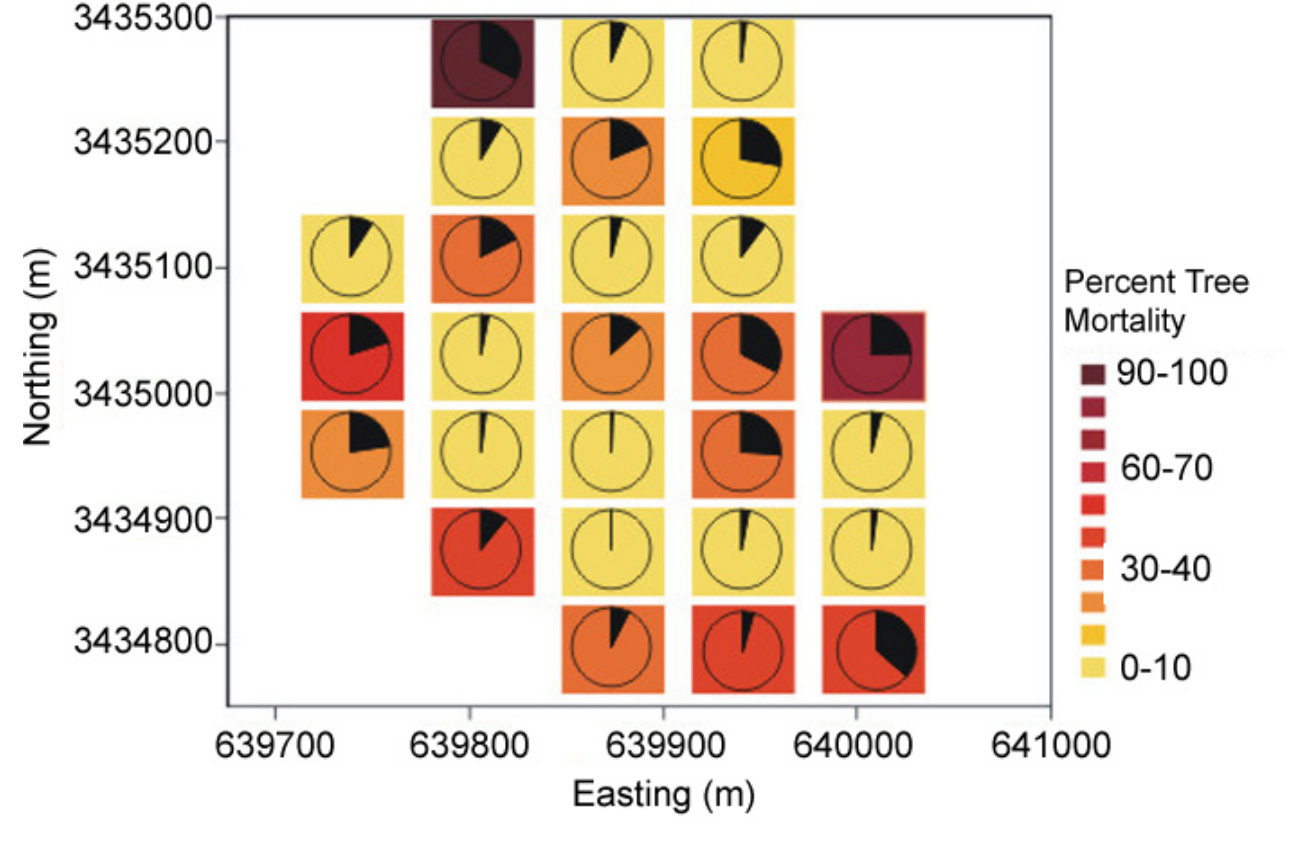
Fig. 3. Spatial distribution of fire damage-tree mortality relationship in a Jeffrey pine-mixed conifer forest in Sierra San Pedro Martir (SSPM), northwestern Mexico, 3 yr after a 2003 wildfire. Pie charts represent forest survey plot locations in a 14-ha watershed. Proportion filled (black area) is the average bark char height converted to percent and color identifies plot-level tree